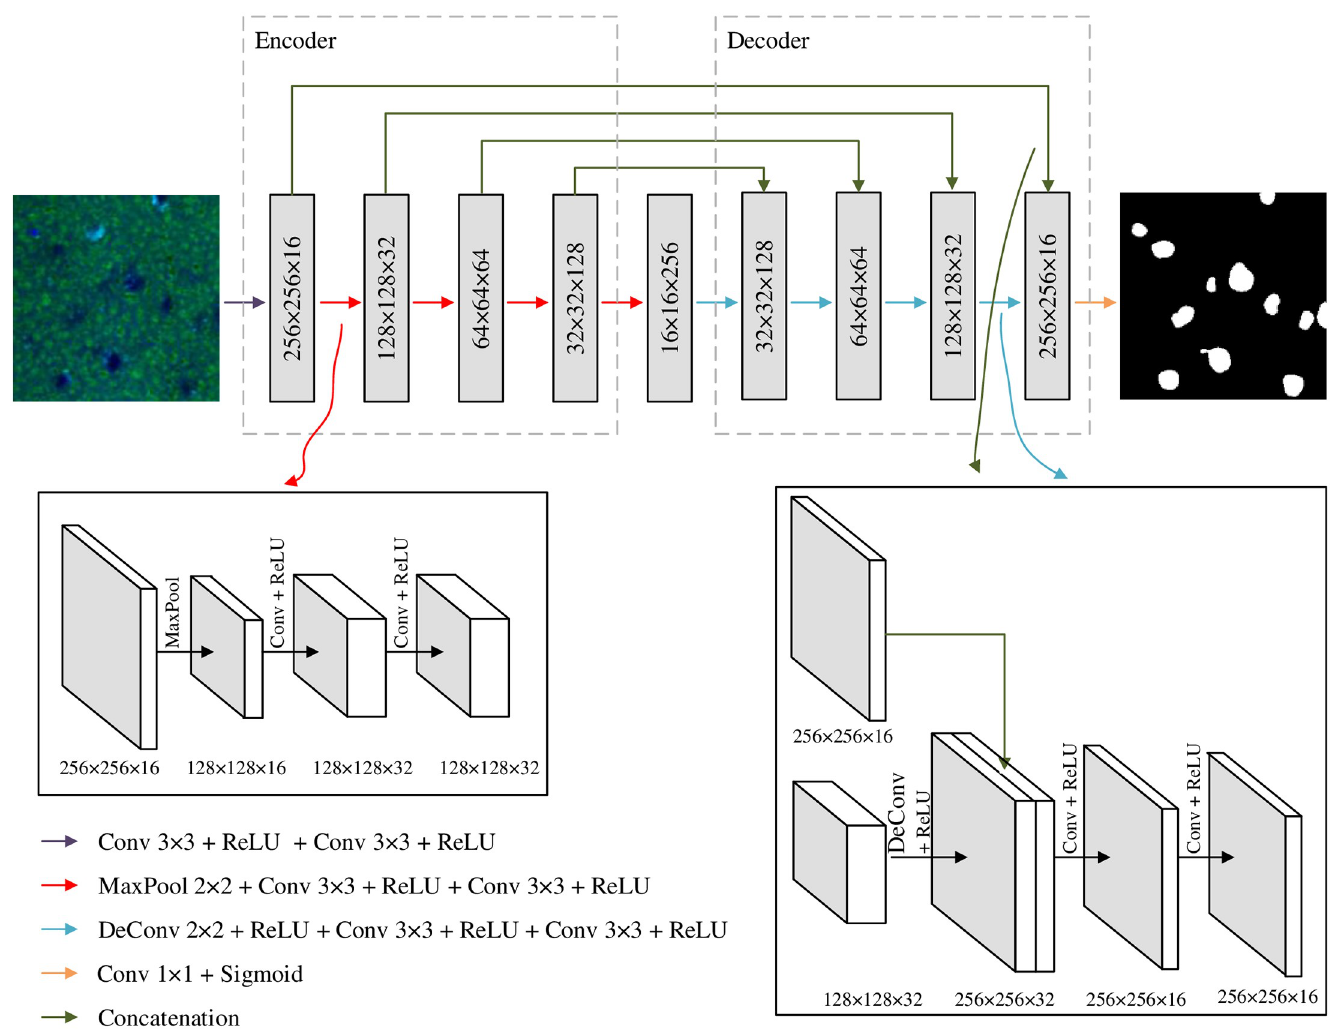
Fig 3. The architecture of the modified U-Net